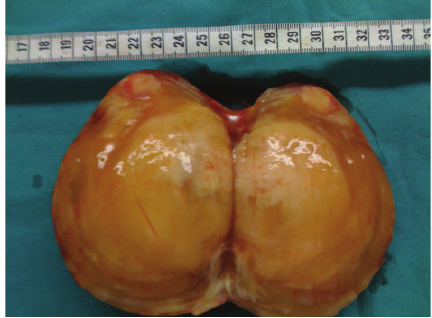
Figure 7: Cut surface of the mass; gelatinous, tan/yellow appear- ance with a solid area at the edge.